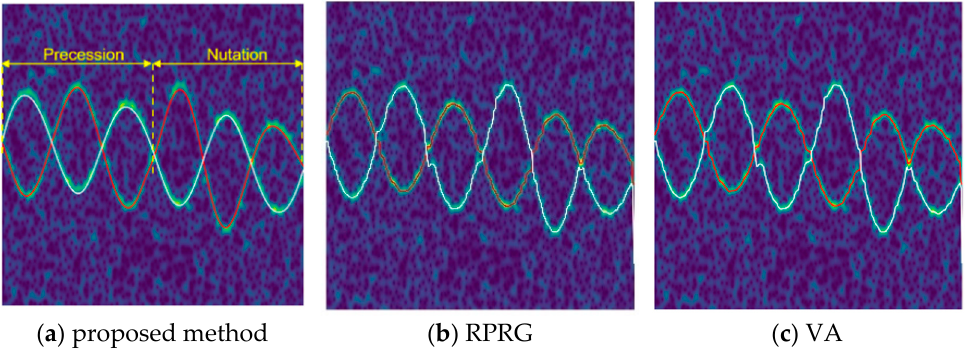
Figure 15. Extraction results of the proposed method, RPRG and VA.